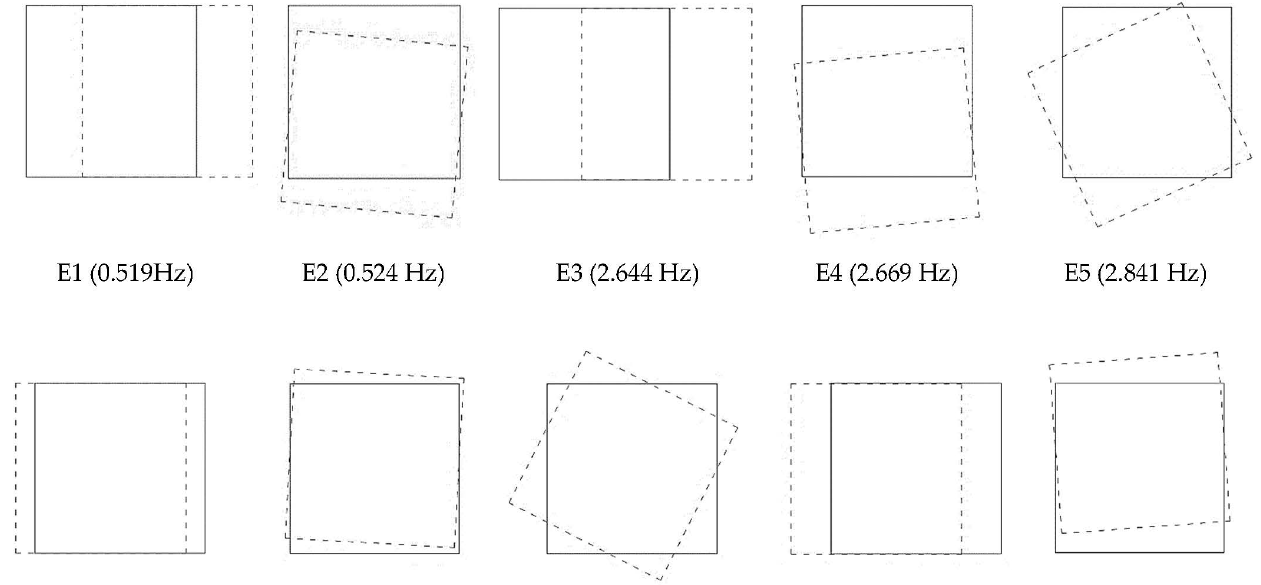
Figure 6. Experimental mode shapes in planar view at 40.64 m to show the bending and torsional natures of the modes (EFDD).